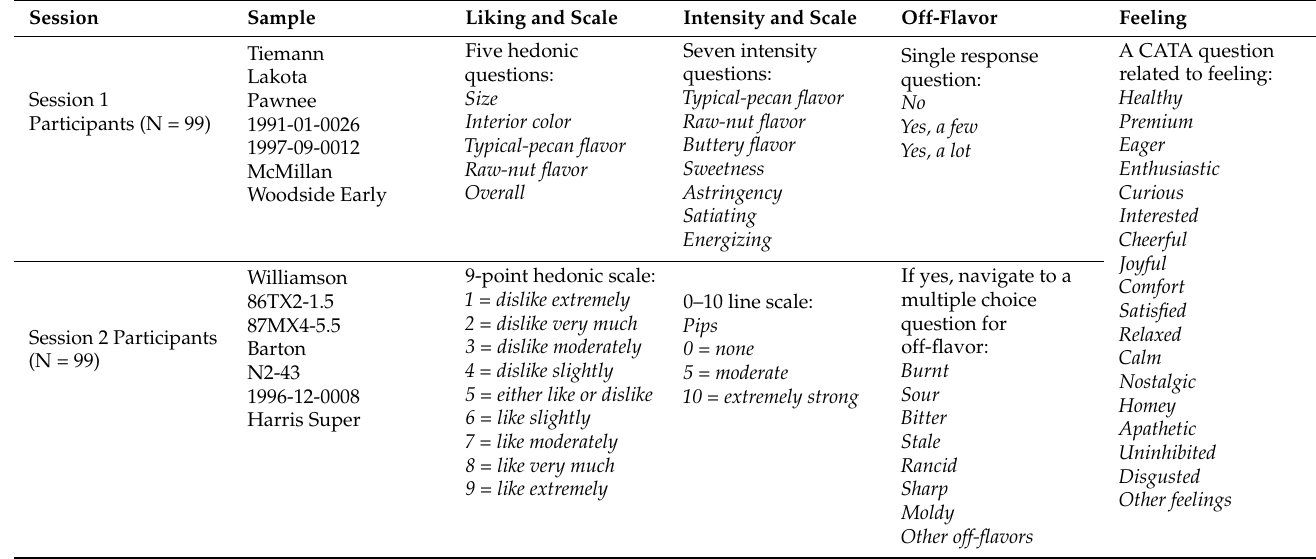
Table 6. Pecan kernel consumer test